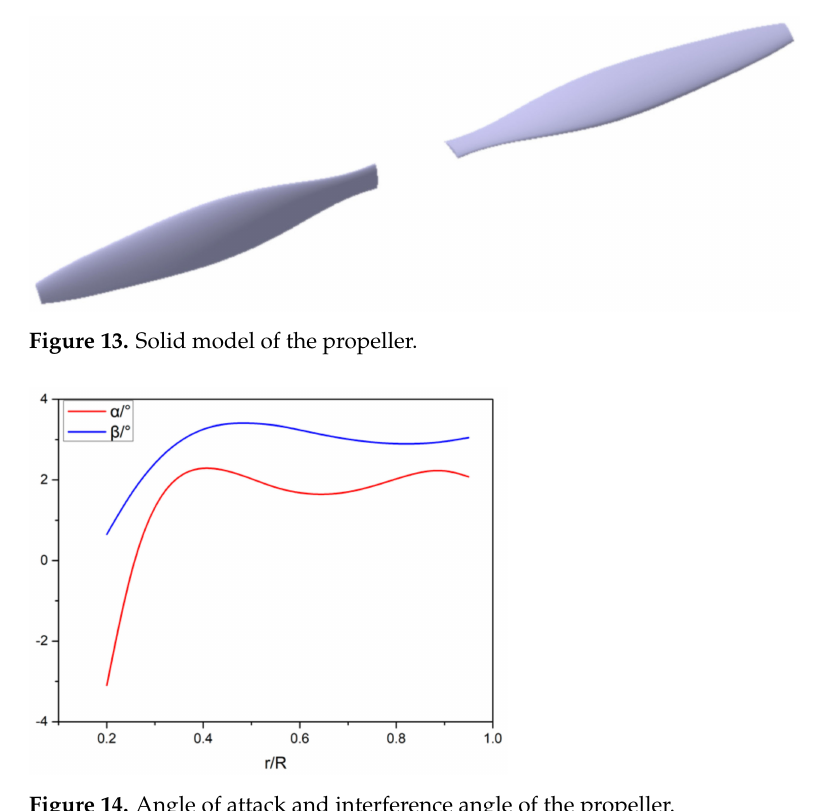
Figure 14. Angle of attack and interference angle of the propeller.